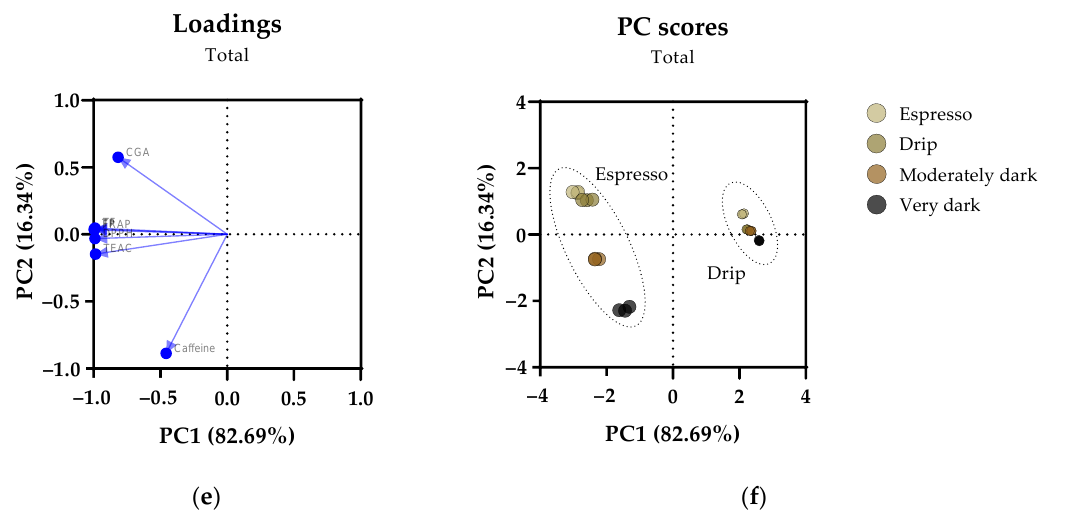
Figure 1. Results of principal component analysis (PCA). ( a , c , e ) Loading plot; ( b , d , f ) score plot. The contents of TP, TF, CGA, along with the estimations of antioxidant activities (TEAC, DPPH radical scavenging activity, and FRAP) of the espresso and drip coffee with various roasting degrees, were analyzed using PCA. TP, total phenolics; TF, total flavonoids; CGA, chlorogenic acids; DPPH, 2,2-diphenyl-1-picrylhydrazyl radical scavenging activity; FRAP, ferric reducing antioxidant power; TEAC, Trolox equivalent antioxidant capacity.